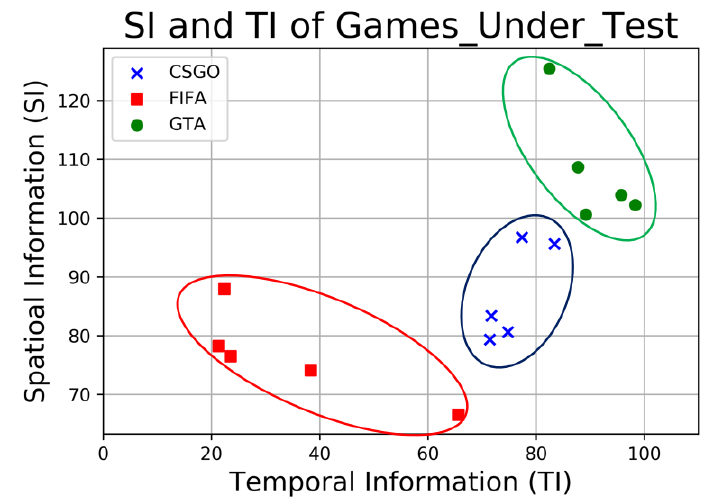
Figure 2. SI and TI of